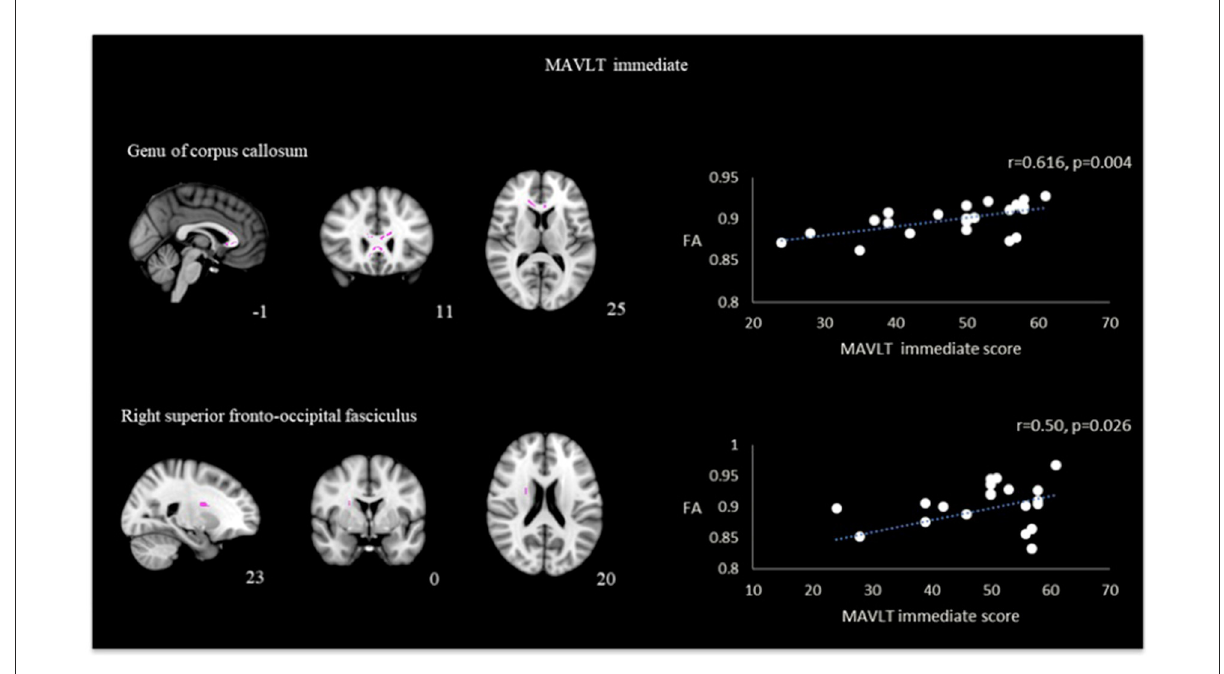
FIGURE4 Correlation between FA and MAVLT immediate recall in the region of genu of corpus callosum and right superior fronto-occipital fasciculus in TBI patients.